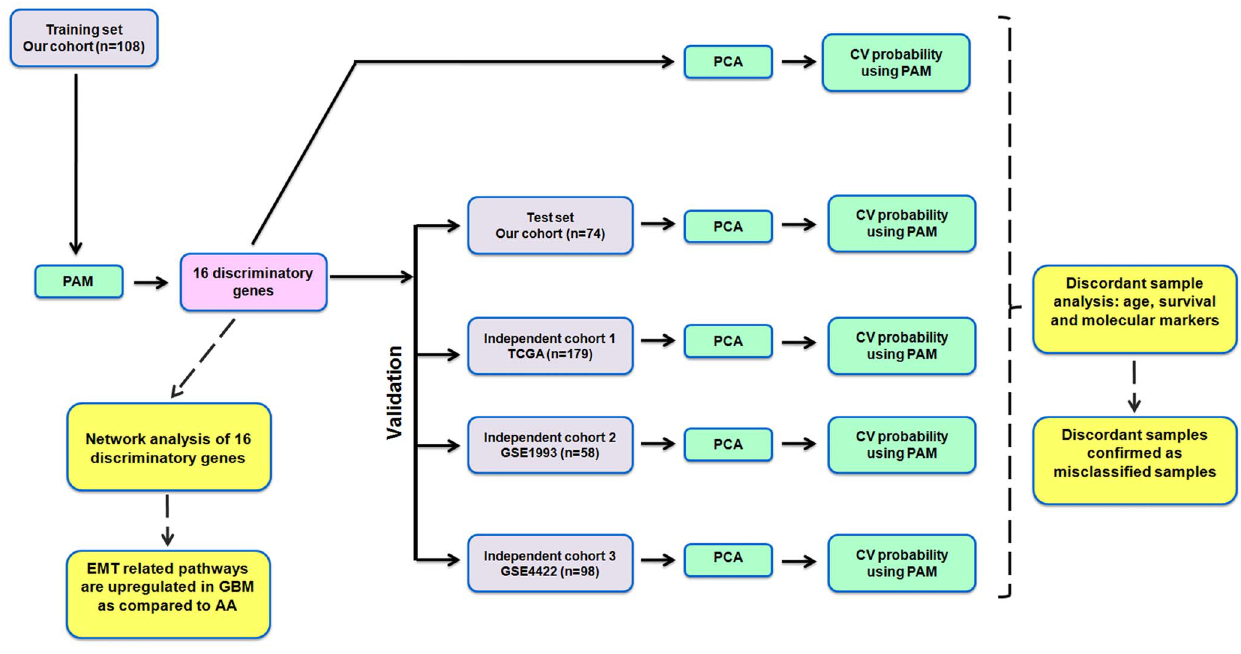
Figure 1. The schematic representation of the work flow of statistical analysis. The expression of 175 genes was subjected to prediction analysis of microarray (PAM) in the training set. PAM analysis identified the 16 discriminatory genes between AA and GBM which was further validated by principal component analysis (PCA) and cross validated probability by PAM. The 16-gene signature was further validated in test set and three independent cohorts of patient samples (GSE1993, GSE4422, TCGA and